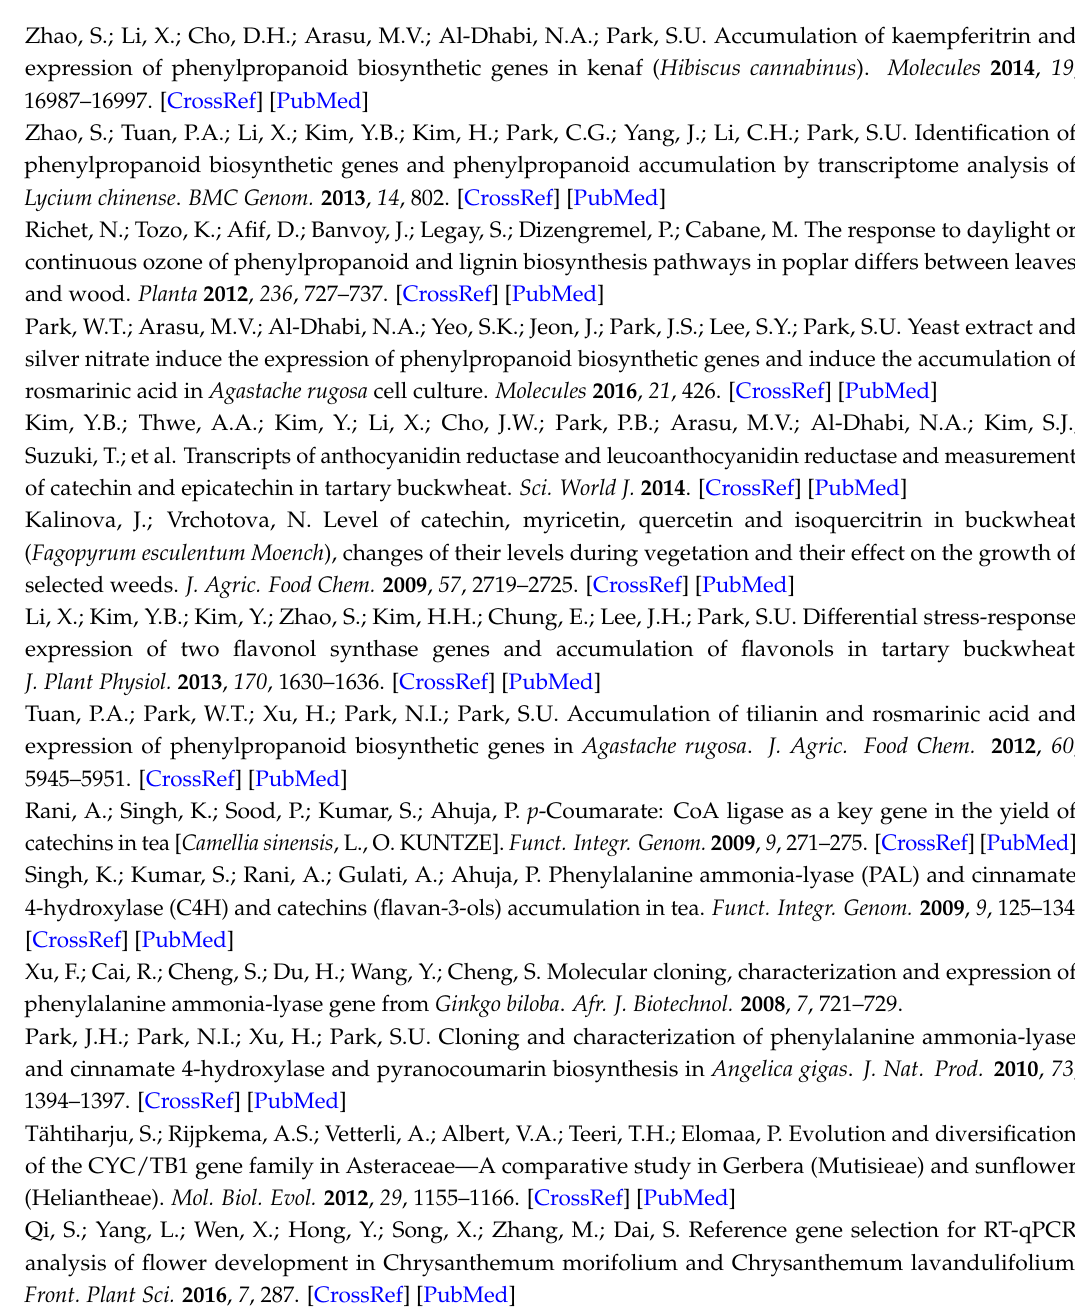
were isolated on a small scale. They are readily analyzed using the procedures